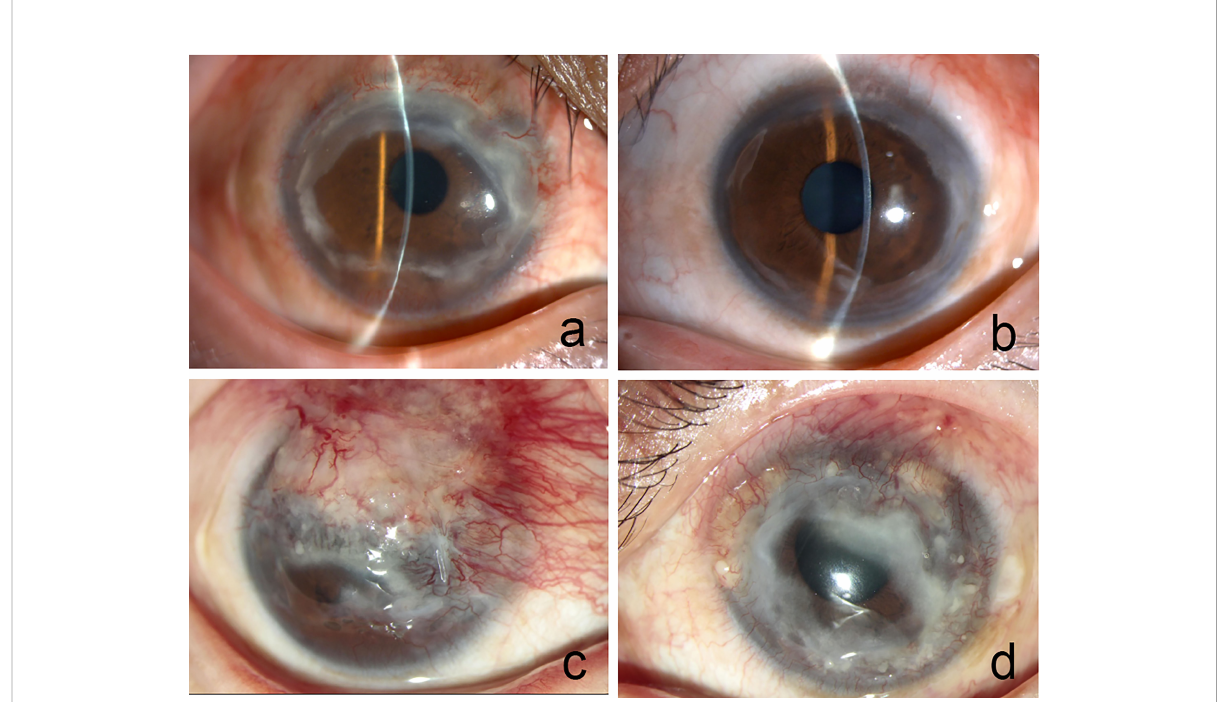
FIGURE 3 Corneal ulcers almost healed up in both eyes ( A right eye, B left eye). the superior two-thirds of the cornea was covered by neovascularization and necrotic tissue in the right eye ( C right eye). Corneal ulceration was observed throughout the cornea except for the central cornea ( D left